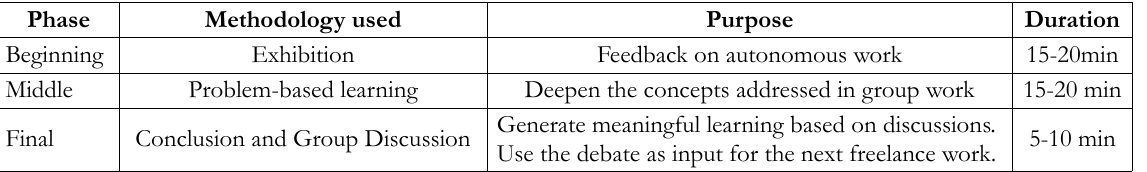
Table 1. Phases of a synchronous class